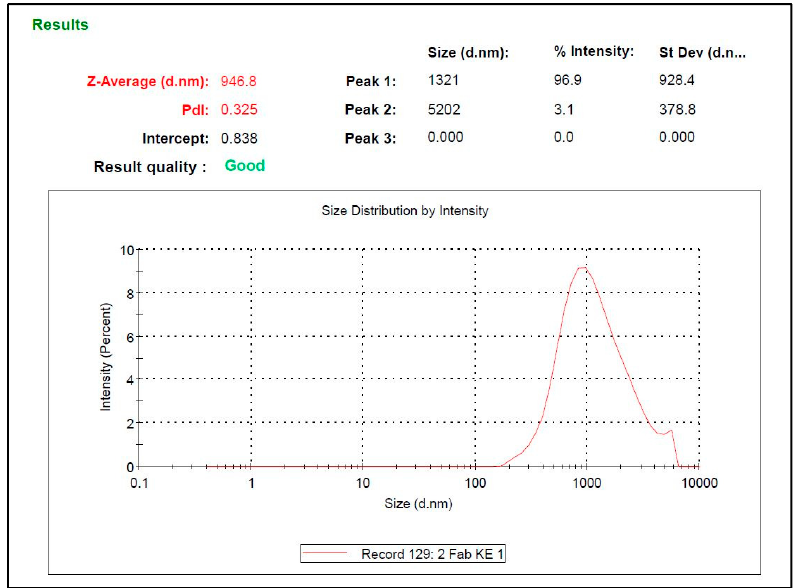
Figure 13. Particle size distribution by intensity of WS 2 particles synthesized using WO 3 prepared by USP as precursor.